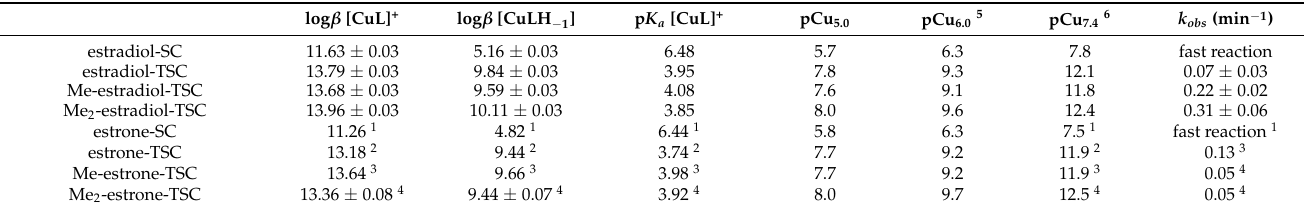
Table 2. Overall stability constants ( β ), p K a of the Cu(II) complexes estradiol-(T)SCs and estrone- (T)SC for comparison, determined by UV–vis titrations, and calculated pCu values at pH 5.0, 6.0, 7.4 using c Cu (II) = 20 µ M, c ligand = 20 µ M. Observed rate constants ( k obs ) obtained for the direct redox reaction of the Cu(II) complexes (25 µ M) with GSH (1.25 mM) at pH 7.4 under anaerobic conditions. (30% ( v/v ) DMSO/H 2 O; T = 25.0 ◦ C; I = 0.1 M (KCl)). log β [CuL] + log β [CuLH − 1 ] p K a [CuL] + pCu 5.0 pCu 6.0 5